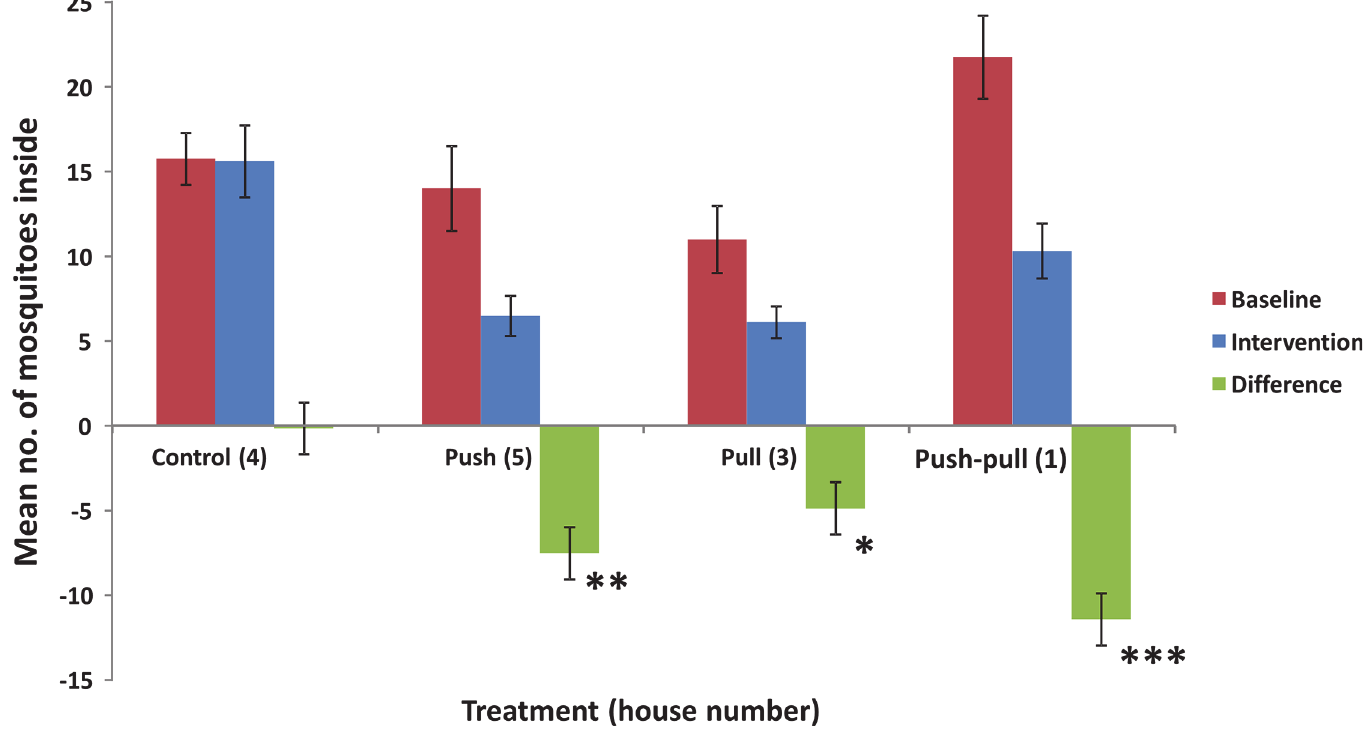
Fig 2. Mean number of mosquitoes caught inside the houses. Error bars indicate standard error of the mean (SEM), n = 8 for the baseline data (n = 7 for house 3) and n = 25 for the intervention data. Asterisks indicate a significant difference-in-differences between the control and the intervention: * p < 0.05; ** p < 0.01; *** p < 0.001.